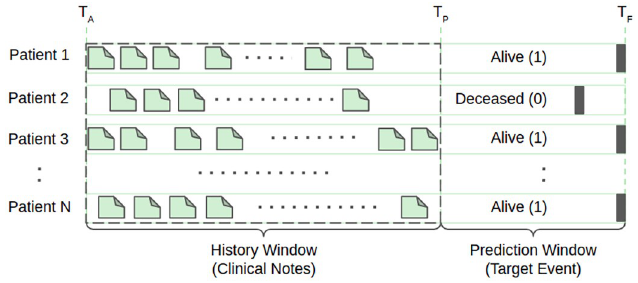
Fig 3. Problem formulation using history window and prediction window. T A , T P , and T F represent the time of admission, end of history window, and end of prediction window, respectively. The folded-corner boxes within the history window represent clinical notes from different categories such as ECG, Echo, Radiology, etc. Each patient has a variable number of clinical notes within the history window. The dark grey band within the prediction window represents the label of the patient. Label 1 means the patient is still alive, and label 0 means the patient has passed